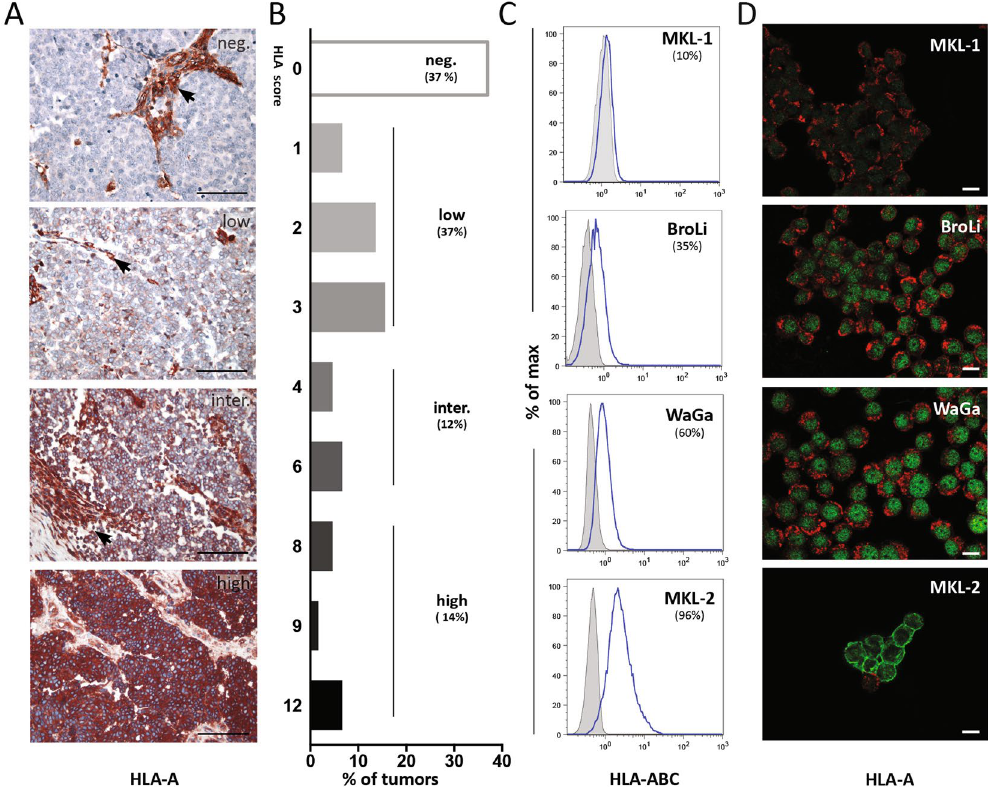
Figure 1. HLA class-I expression by MCC tumors in situ and MCC cell lines in vitro . ( A , B ) 56 MCC tumor samples of 40 patients were analyzed by immunohistochemistry for the expression of HLA-A. Samples were scored from 0 to 3 for staining intensity and from 0 to 4 for the frequency of positive tumor cells; a combined HLA-A expression score was calculated by multiplying both scores. One representative tumor for each HLA score group (negative, low, intermediate and high) is depicted in ( A ); Arrows indicate stromal cells as an internal positive control; scale bar represents 100 µ m. ( C , D ) Four MCPyV + MCC cell lines were analyzed for their HLA class-I expression in vitro . ( C ) HLA class-I surface expression was detected by flow cytometry using an HLA-ABC detecting antibody (clone W6/32, blue line); matched isotype controls are depicted as grey filled histogram. One representative histogram of triplicates is shown for each cell line. ( D ) The cellular localization of HLA class-I was determined by immune fluorescence using wheat germ agglutinin (Alexa fluor 647, red) as membrane marker and a HLA-A detecting antibody (clone EP1395Y) with a dylight 488 labeled secondary antibody (green). Representative images for each cell line were captured with a confocal microscope; scale bars represent 10 µ